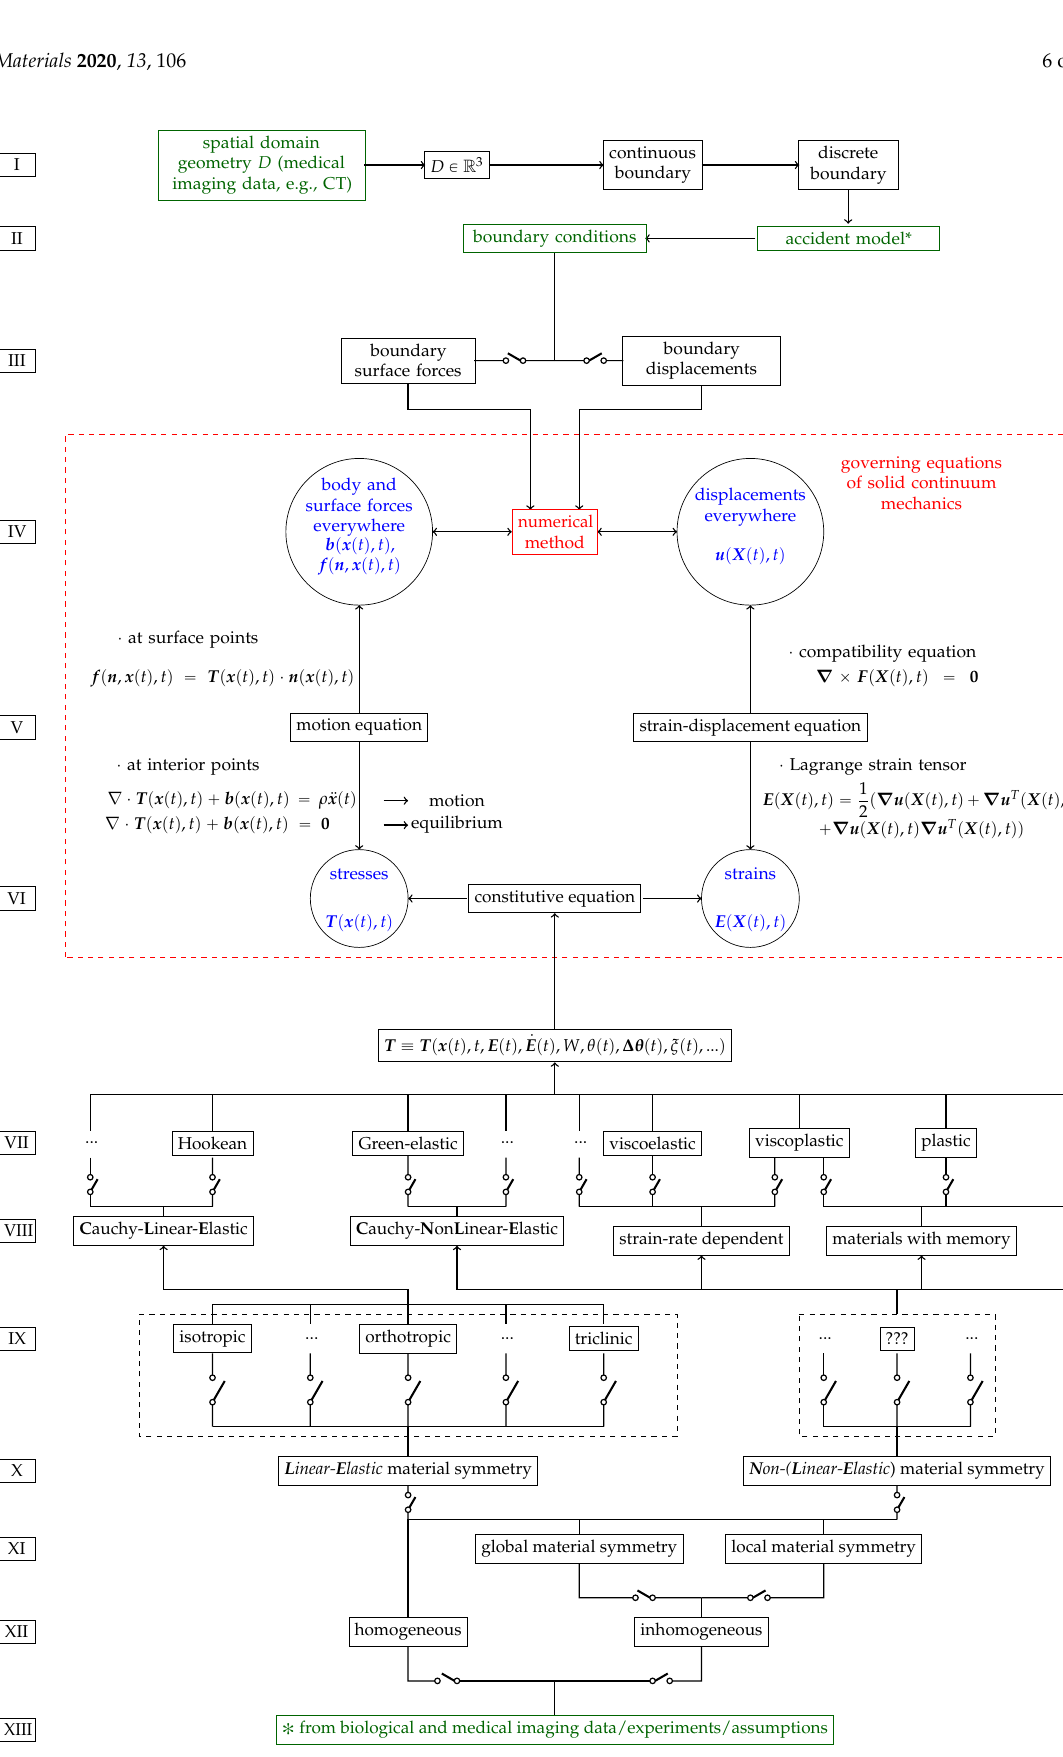
Figure 1. Modelling of a solid continuum mechanics problem for